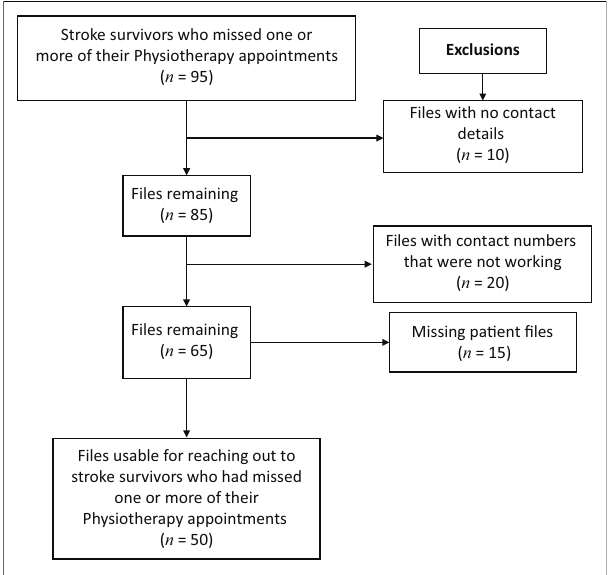
FIGURE 1: Identification of files for potentially eligible stroke survivors who missed one or more of their physiotherapy appointments.